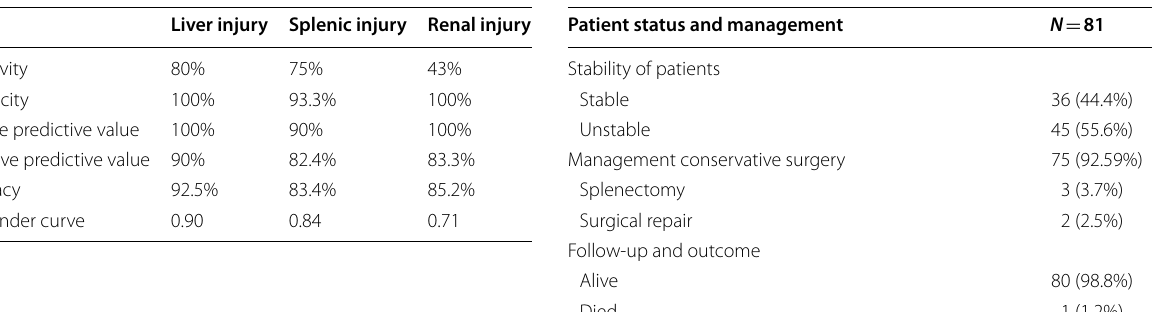
Table 8 Outcome and management of studied patients in